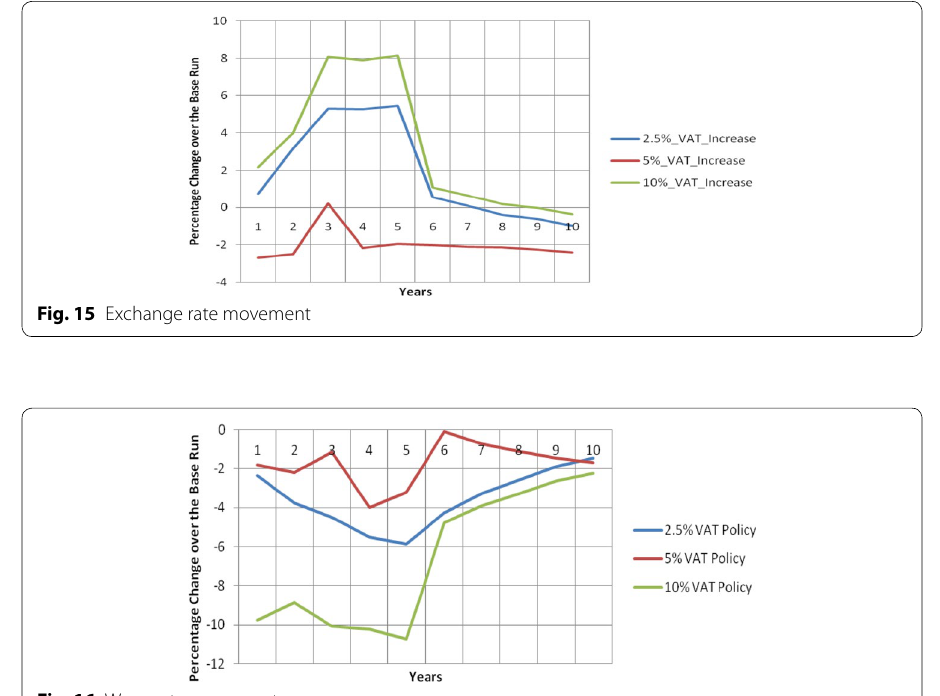
Fig. 16 Wage rate movement